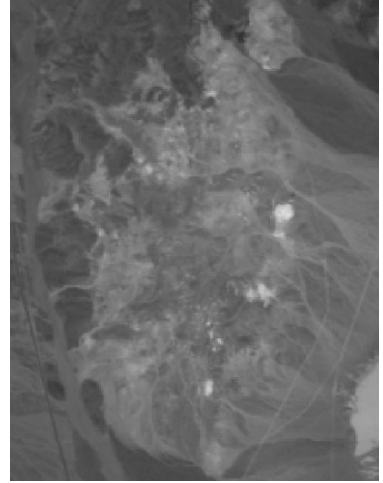
Figure 12. Subimage of Cuprite data (band 80).